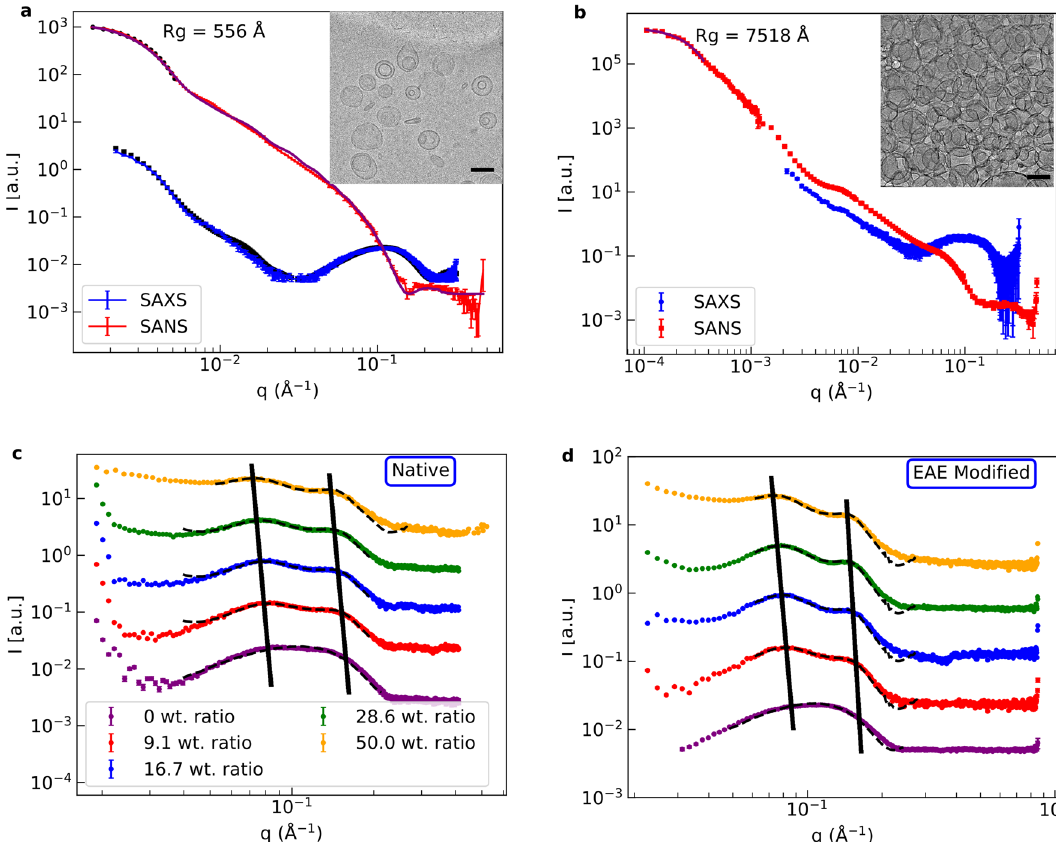
Figure 1. ( a ) SANS, synchrotron SAXS and cryo-TEM of native liposomes in absence of MBP. The SANS and SAXS data have been globally fitted with a simple box model. The fits are indicated by continuous lines. ( b ) SANS and synchrotron SAXS of native liposomes with 16.7 wt. ratio MBP and cryo-TEM of native liposomes with 40 wt. ratio MBP. The lipid concentration of the SANS measurements was 2.5 mg/ml, in synchrotron SAXS 5 mg/ml and in cryo-TEM 1 mg/ml. The concentration in SAXS was chosen higher for intensity reasons and the concentration of cryo-TEM lower as the blotting process increases the intensity again. The black bar in the cryo-TEM images corresponds in each case to 100 nm. In ( c ) and ( d ) SAXS data of native and EAE modified liposomes with MBP (9, 16.7, 28.6 and 50 wt. ratio) have been fitted globally by a LUV + MLV model in the region of interest. SAXS data with 0 wt. ratio MBP were fitted with the LUV model. The lipid concentrations in the SAXS measurements without MBP were 10 mg/ml and with MBP 5 mg/ml. Here, the global fit parameters of SAXS and SANS measurements of the respective lipid compositions are used for the LUV part of the model. These fits are indicated by the dashed black lines in the respective plots. For better visibility the different datasets in ( c ) and ( d ) have been vertically